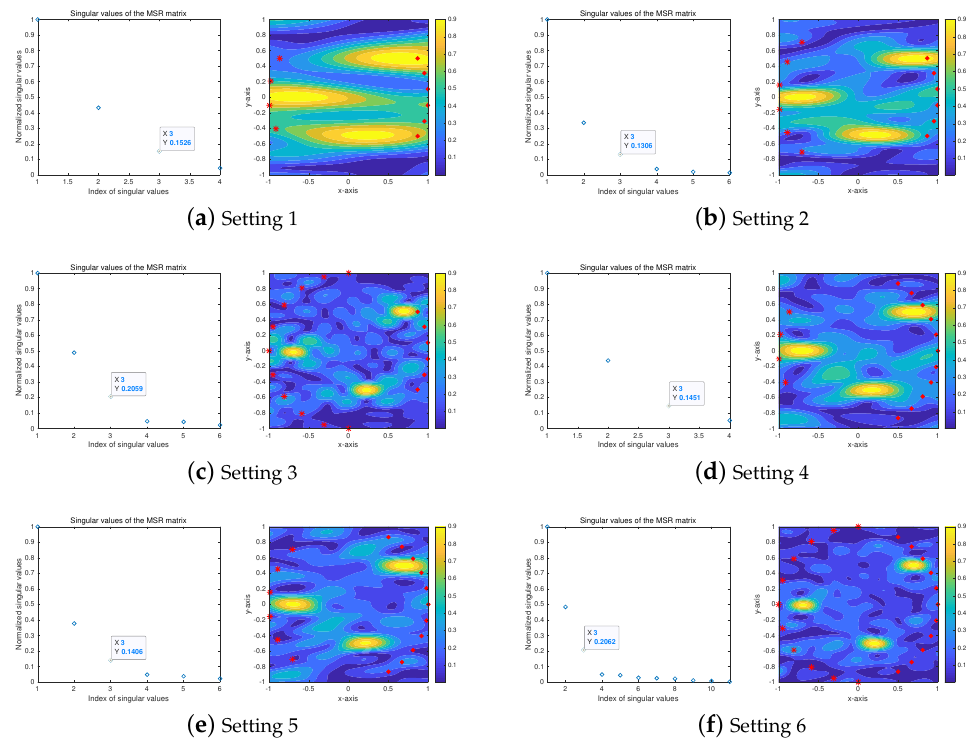
Figure 4. (Example 1) maps of F ε ( r ) . The red-colored marks ◦ and ∗ denote the incident and observation directions,